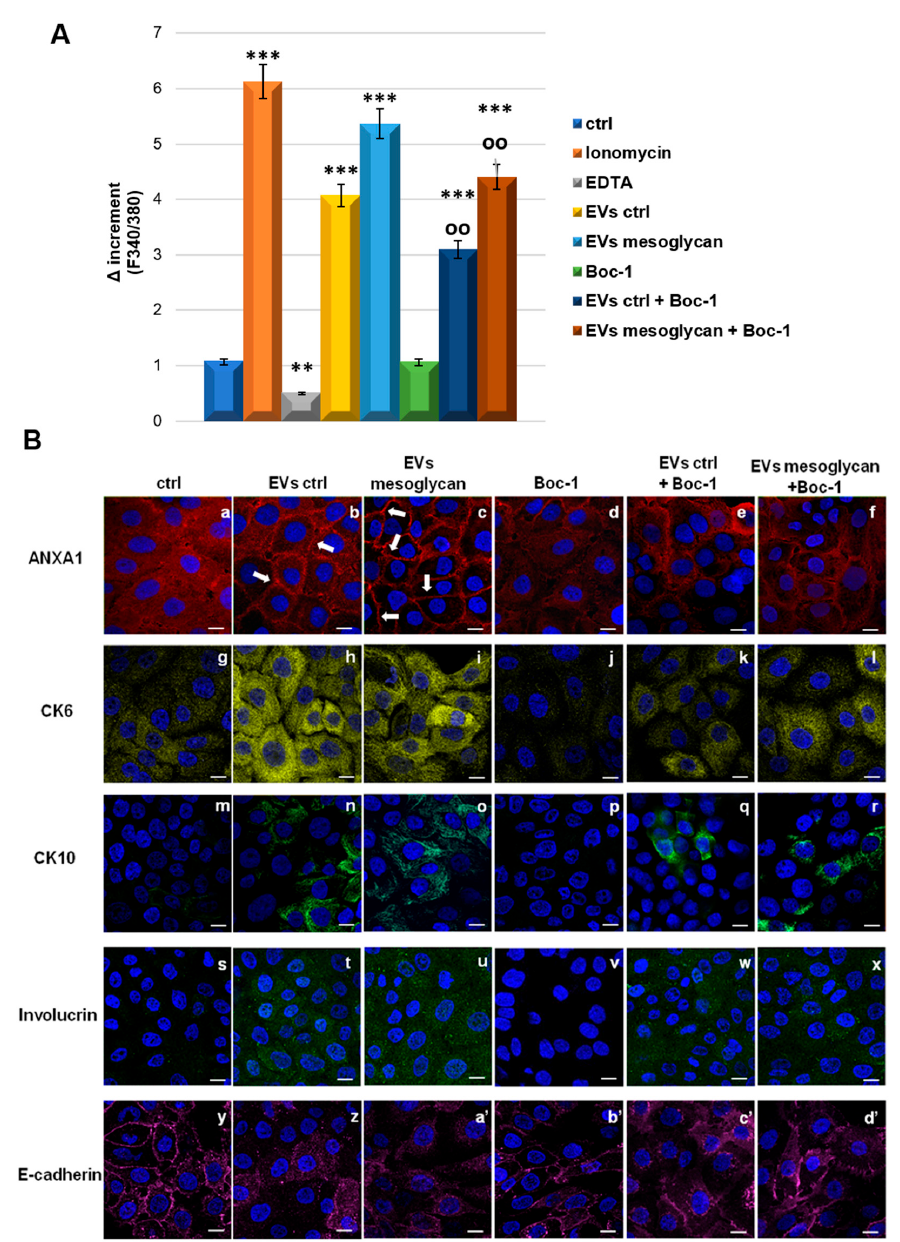
0.01; *** p < 0.001 treated cells vs non treated control; oo p < 0.01 EVs ctrl + Boc-1 and EVs